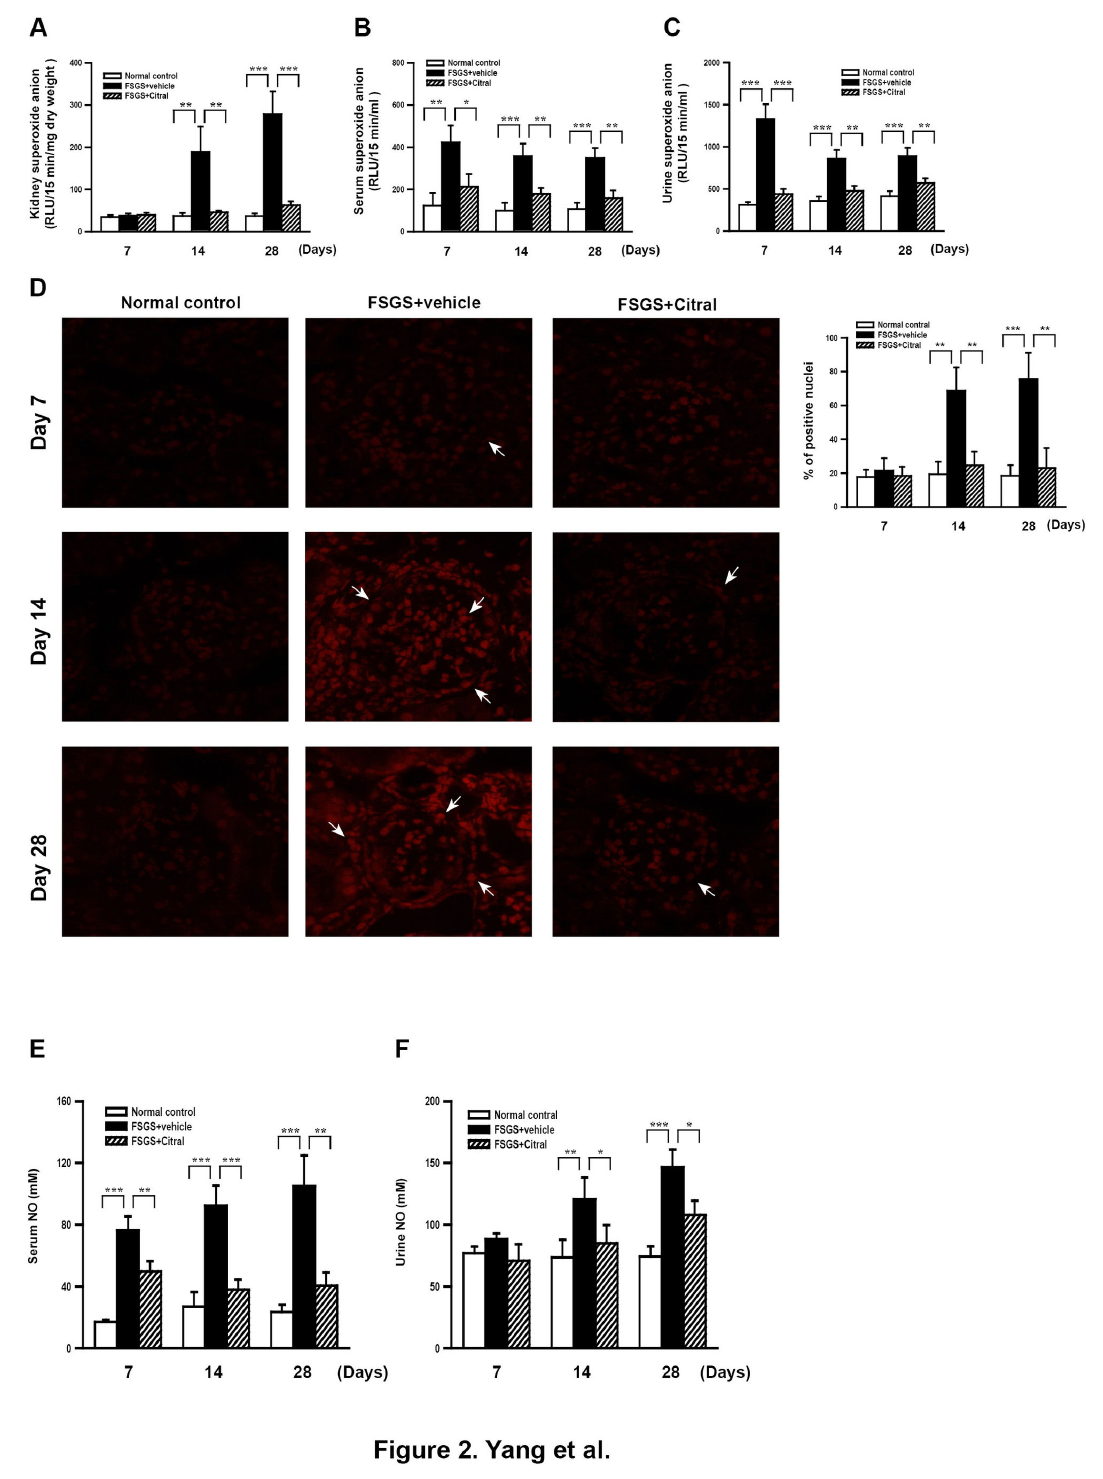
Figure 2. ROS/NO levels. (A-C) Superoxide anion levels in renal tissue (A), serum (B), and urine (C). (D) Kidney in situ ROS production demonstrated by DHE labeling. The arrows indicate positive staining cells. Original magnification, 400×. The scoring is shown on the right. (E, F) NO levels in serum (E) and urine (F). In the histograms, the data are the mean±SEM for seven mice per group. * p < 0.05, ** p < 0.01, *** p < 0.005. doi: 10.1371/journal.pone.0074871.g002 PLOS ONE |